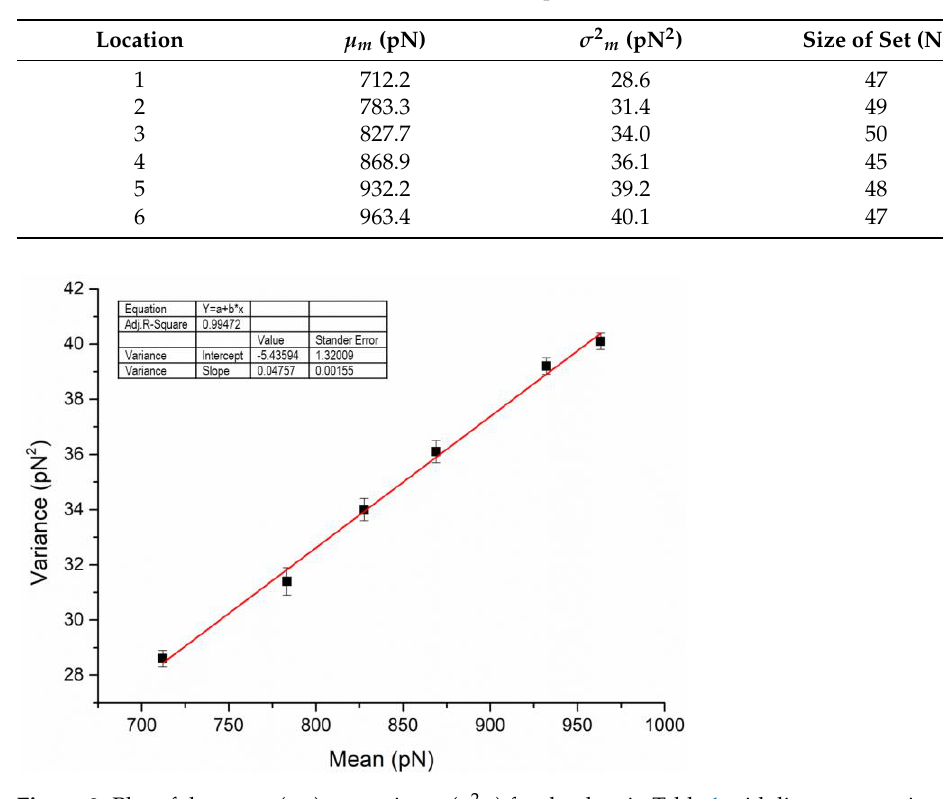
Figure 3. Plot of the mean ( μ m ) vs. variance ( σ 2 m ) for the data in Table 1 with linear regression. Each point represents a dataset collected at one of six randomly chosen sites. (R 2 = 0.99472).